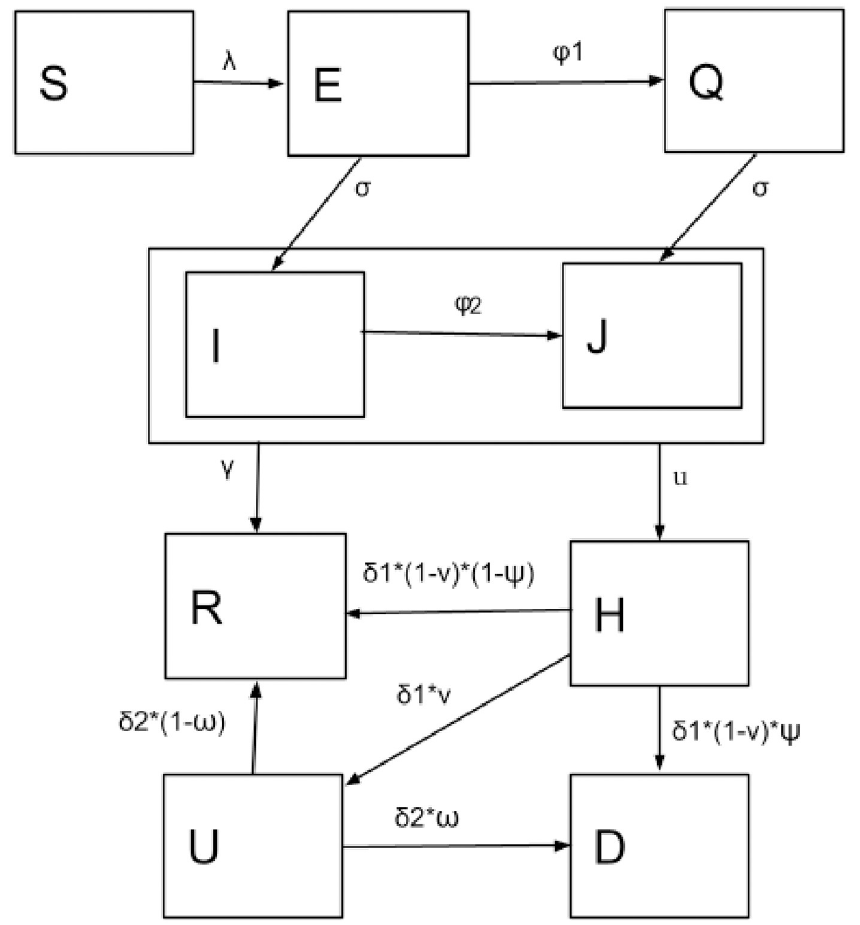
Fig 2. Flow diagram of the SEIR model for COVID-19 transmission dynamics. Boxes represent disease state compartments for Susceptible ( S ), Exposed ( E ), Infectious ( I ), and Removed ( R ), with additional compartments for Quarantine ( Q ), Isolation ( J ), Hospitalized in the general ward ( H ), Hospitalized in the ICU ( U ) and Dead ( D ). Arrows represent flow between compartments with the flow determined by their corresponding parameter values. Parameter values are further explained in Table